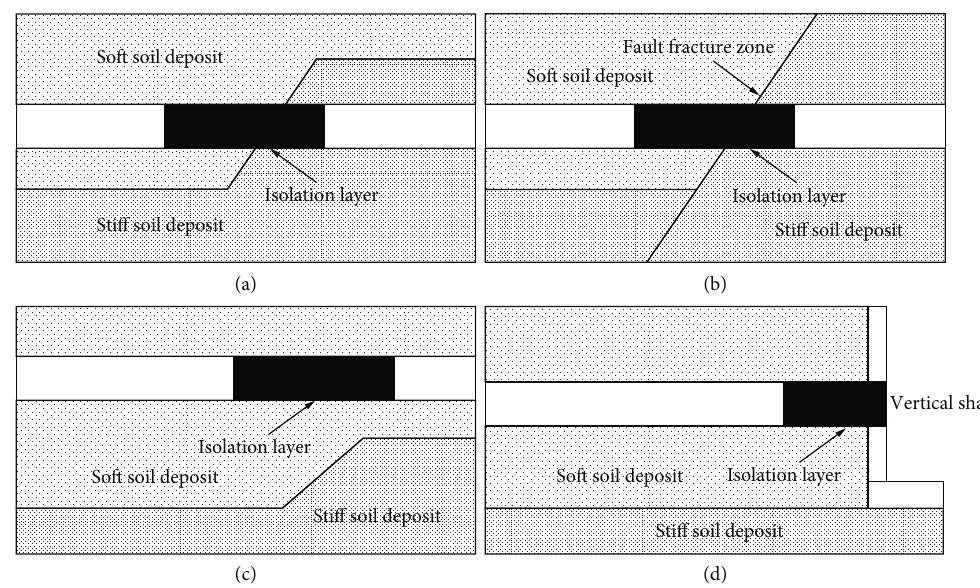
Figure 1: Concepts of a seismic isolation layer for shield tunnels. (a) Traversing the boundary between a soft soil deposit and a stiff soil deposit; (b) traversing a fault fracture zone; (c) underlying boundary between a soft soil deposit and a stiff soil deposit; (d) junction with a vertical